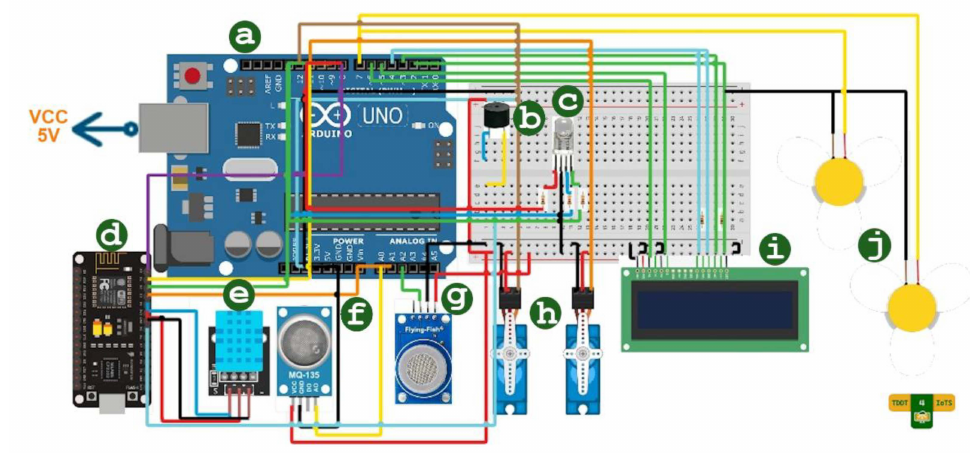
Figure 3. Design of the IdeAir device.